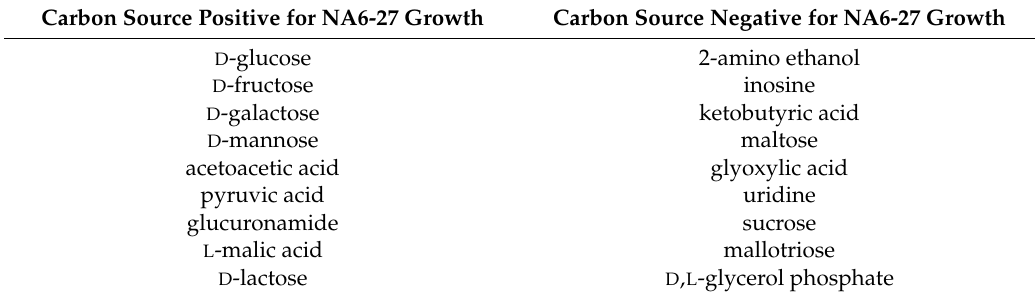
Table 2. Biolog assays. Carbon source utilization by GSL strain, NA6-27. Sources that resulted in observed growth are indicated in the left column, and sources that did not promote growth are listed in the right